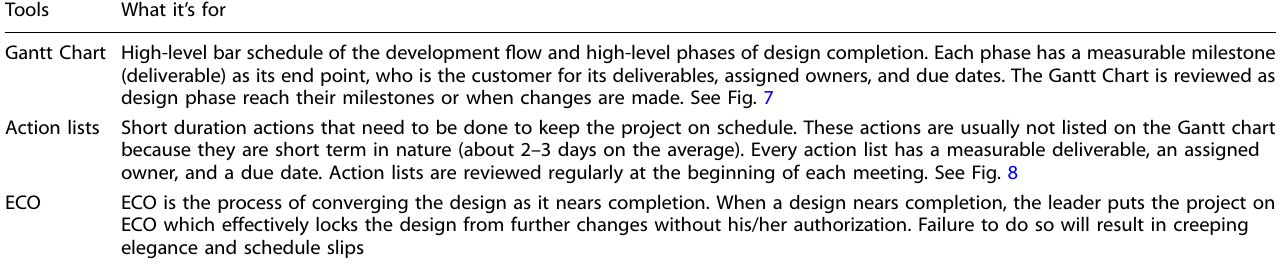
Table 3. Team leader tools Tools What it ’ s for